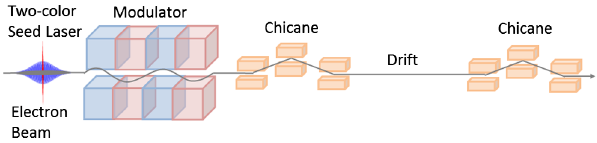
FIG. 1. Layout of seeding scheme prior to the FEL radiator. A modulator is followed by a bunch compressor chicane and a 27-m-long drift section with tightly focused electron beam optics. After the drift, there is an additional chicane directly prior to the FEL radiator.